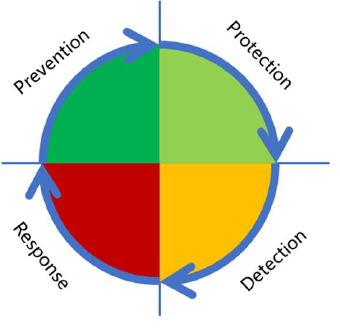
Figure 2. Cyber security risk control Figure 1. Architecture for IHEP web services